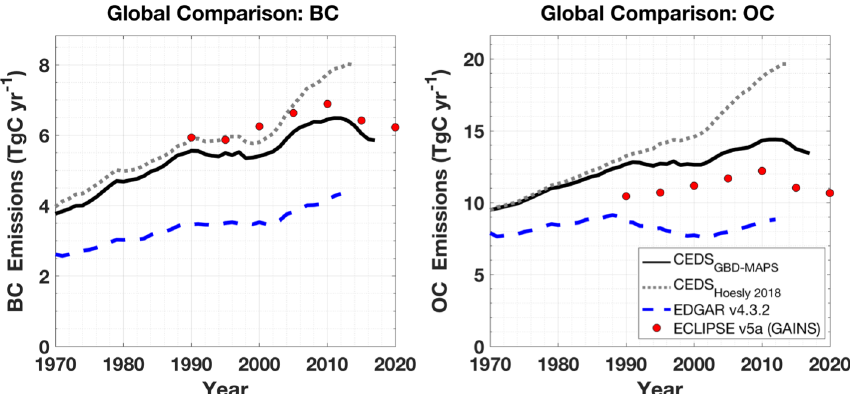
Figure 5. Comparison of global inventories of BC and OC emissions. Total EDGAR v4.3.2 and GAINS (ECLIPSE v5a) emission inventories shown without agricultural waste burning and aviation emissions. CEDS GBD-MAPS emissions of BC and OC are not scaled to EDGAR or GAINS